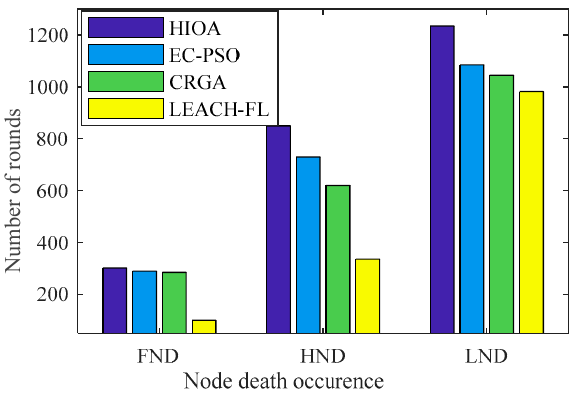
Figure 6. Network lifetime over round.